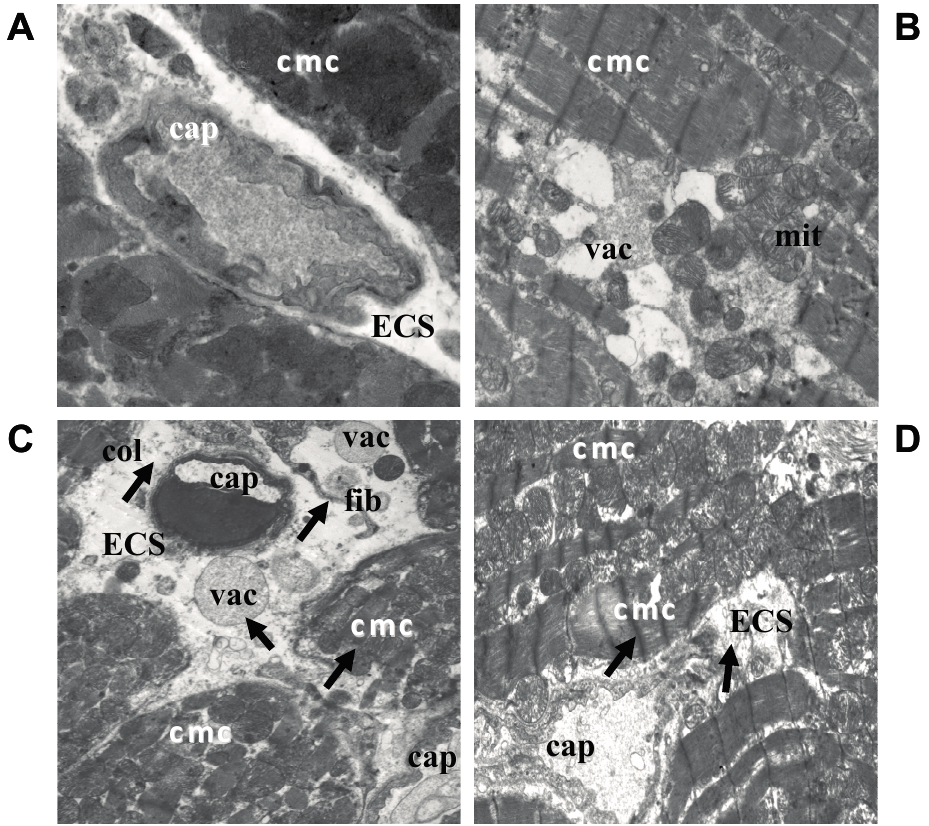
Figure 1. Electron microscopic images showing qualitative changes in ultrastructure of the left ventricle of rat hearts. ( A ) Electron micrograph of control rat heart showing normal architecture of cardiomyocytes and without changes in ECS; ( B ) Electron micrograph of the myocardium after treatment with QCT; ( C ) Electron micrograph of the myocardium affected with DOX demonstrating subcellular alterations of cardiomyocytes and extracellular space (arrows); ( D ) Ultrastructure of the myocardium of rats treated with both QCT and DOX. Arrows indicate improvement of some deleterious subcellular alterations induced by DOX. ECS: extracellular space; cmc: cardiomyocytes; cap: capillary; col: collagen; mit: mitochondria; vac: vacuole; fib: fibroblast. ( A ) original magnification ×8000; ( B ) original magnification ×8000; ( C ) original magnification ×6000; ( D ) original magnification